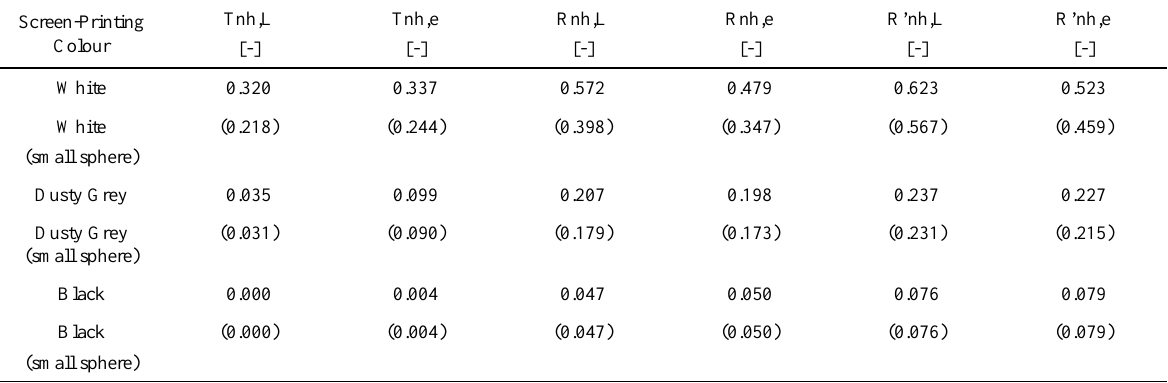
Table 1: Transmittance and reflectance values according to EN 410:2011 for 6 mm low-iron glass panes with white, dusty-grey or black screen- printed coatings, using integrating spheres of diameter 220 mm (small) and 620 mm (large). The figures shown in parentheses are the results of measurements made using the small sphere, which are clearly too low in the cases of the white and the grey fritted glass. T = transmittance (= τ in EN 410), R = reflectance (from the glass side), R’ = reflectance (from the screen-printed side), nh = normal-hemispherical, L = light, e = (solar) energy. Only the first two digits after the decimal point are significant. The third digit is used only to indicate very small